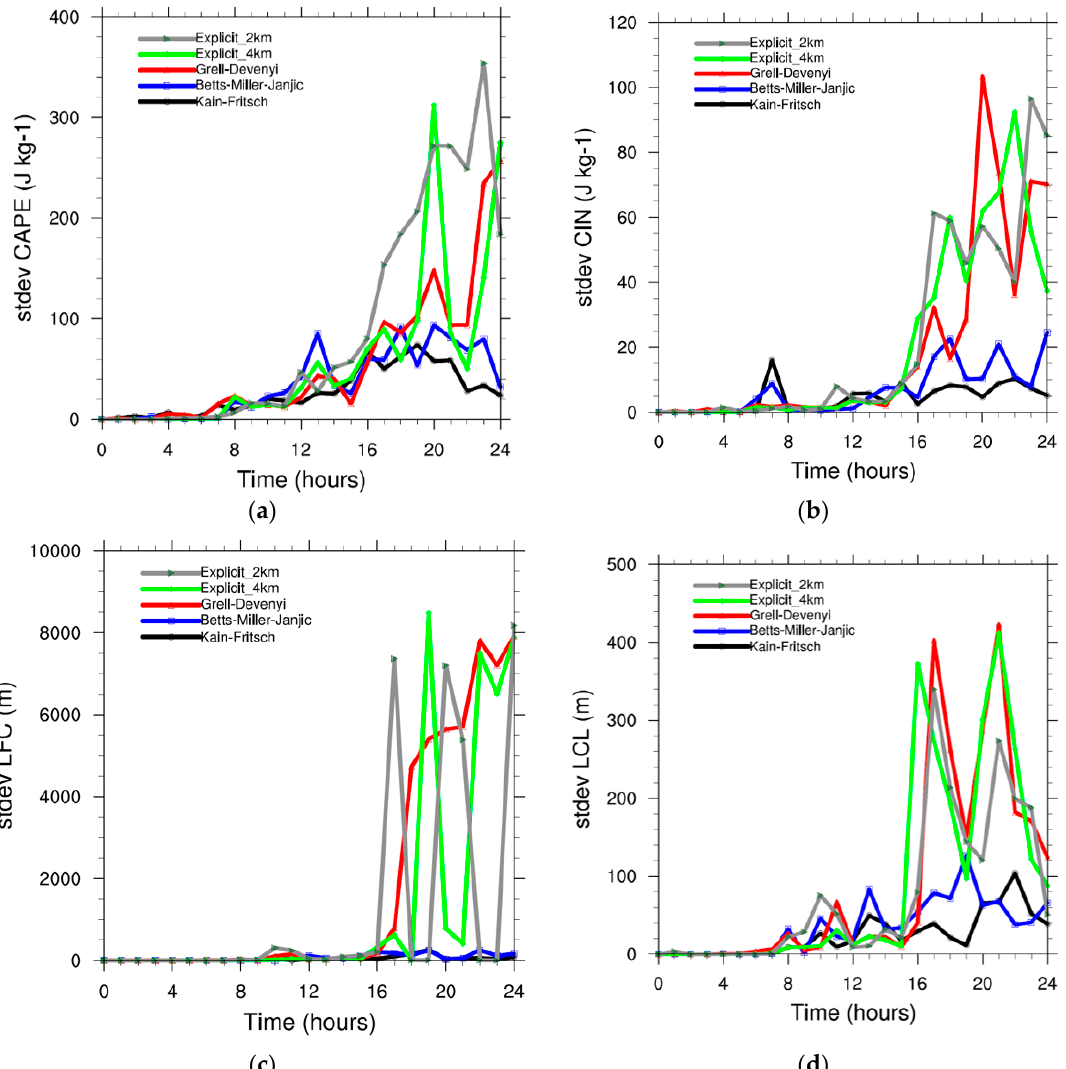
Figure 7. Modelled standard deviation of ( a ) CAPE (J kg − 1 ), ( b ) CIN (J kg − 1 ), ( c ) LCL (m) and ( d ) LFC (m) for a domain of 80 × 112 km around the study area of Luyksgestel, due to uncertainty in the spatial soil moisture distribution.